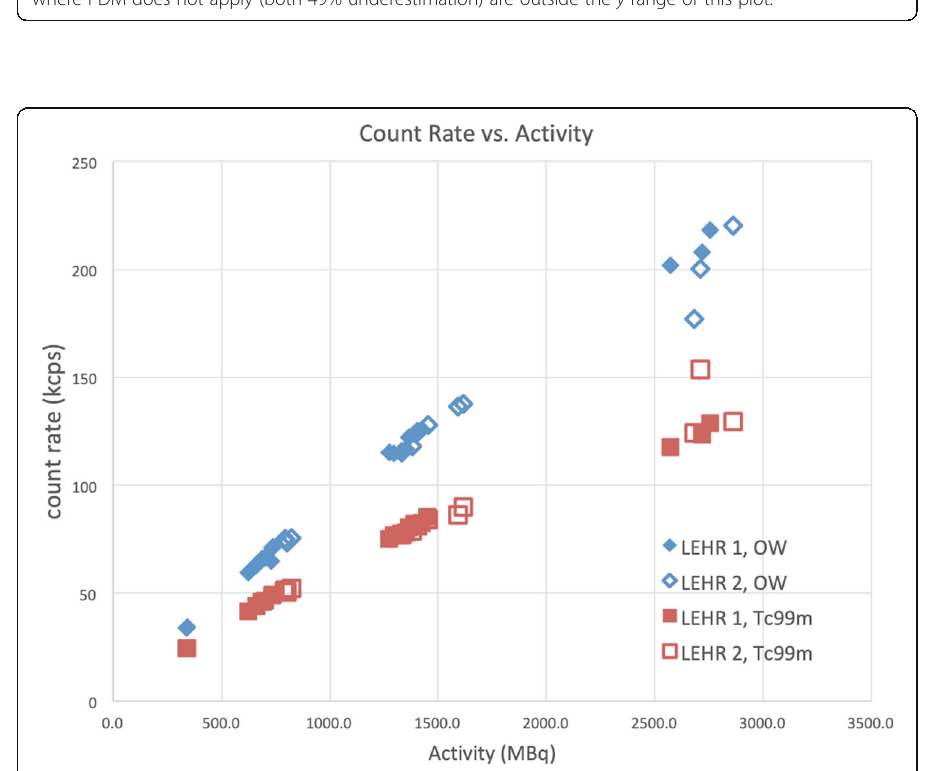
Fig. 6 Extrinsic count rate measurement with point source. Measured count rates, R ′ (kcps), vs. A (MBq) for extrinsic (LEHR collimator) measurements of a point source. LEHR 1 refers to the first, LEHR 2 to the second measurement, of detector 2 for both energy windows: OW (blue diamonds) and 99m Tc (red